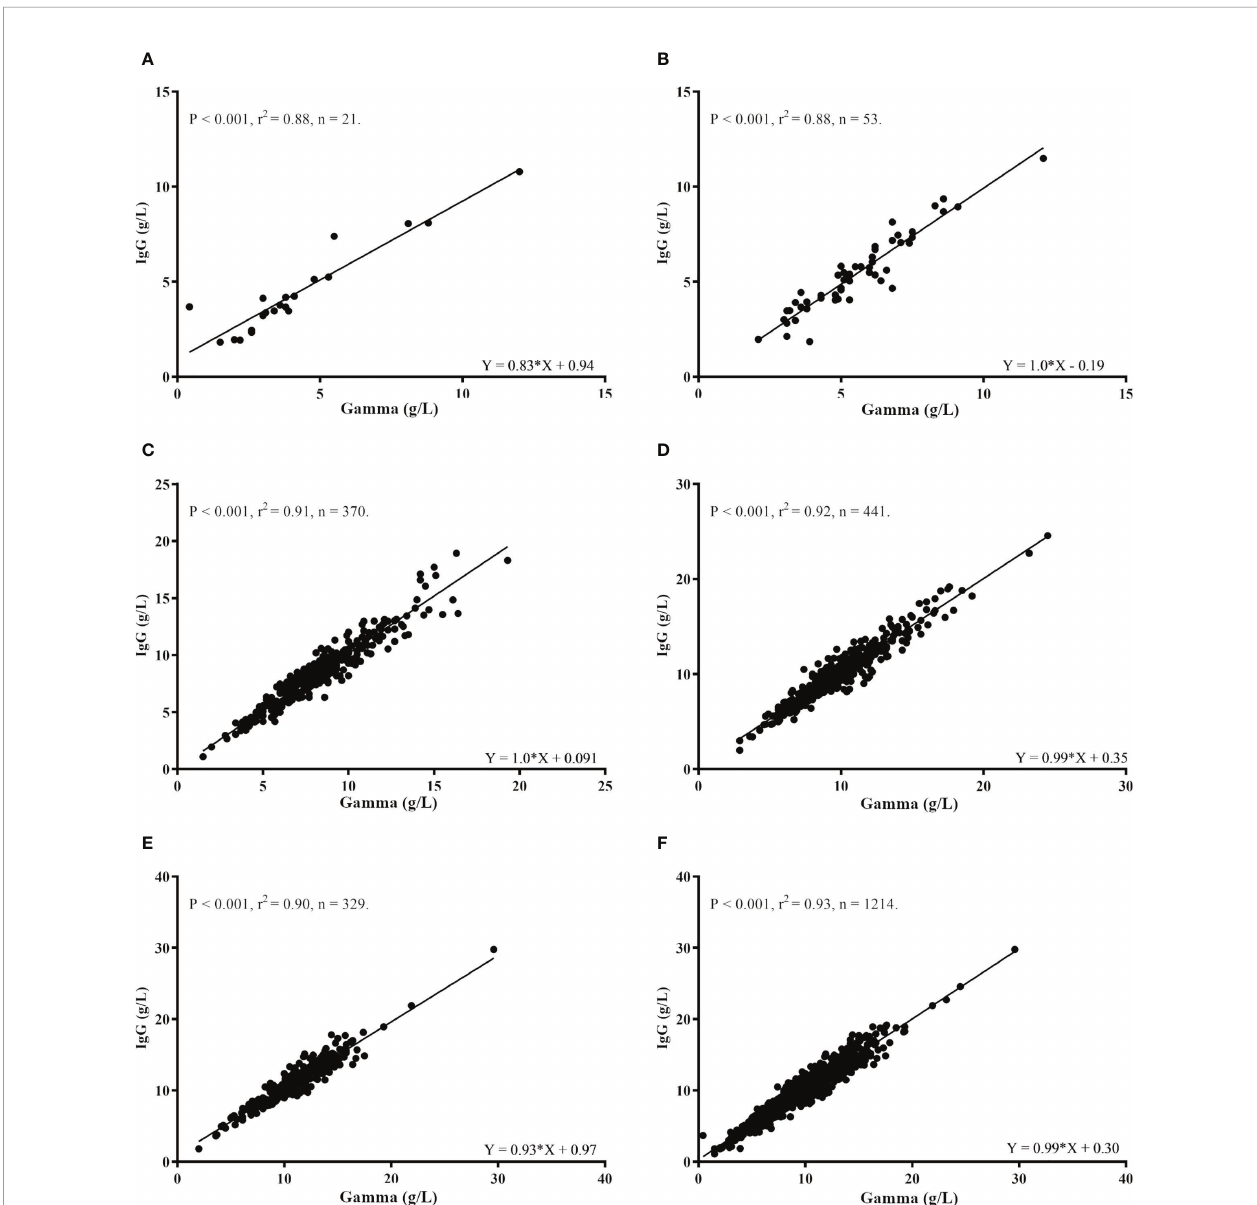
FIGURE 3 | Correlation between IgG (g/L) and Gamma globulin values (g/L) according to age groups. (A) 1 to 5 months. (B) 6 to 11 months. (C) 1 to 3 years. (D) 4 to 9 years. (E) 10 to <18 years. (F) All age groups